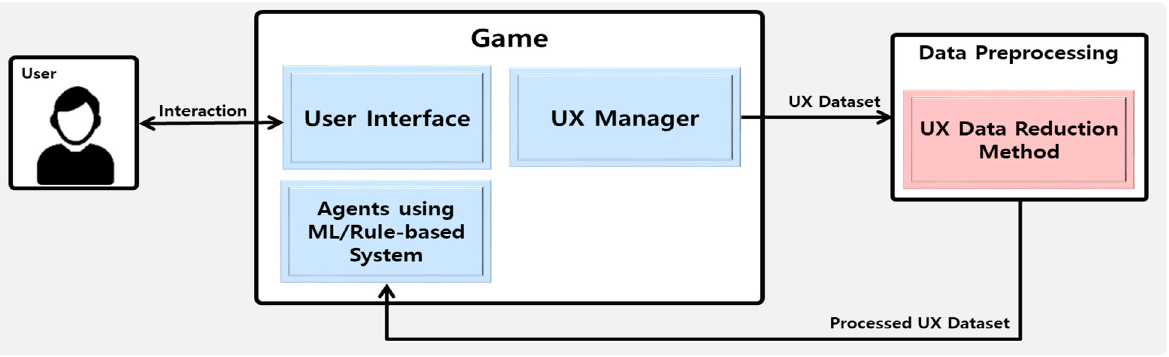
Figure 1. Traditional game agent system based on UX Framework.